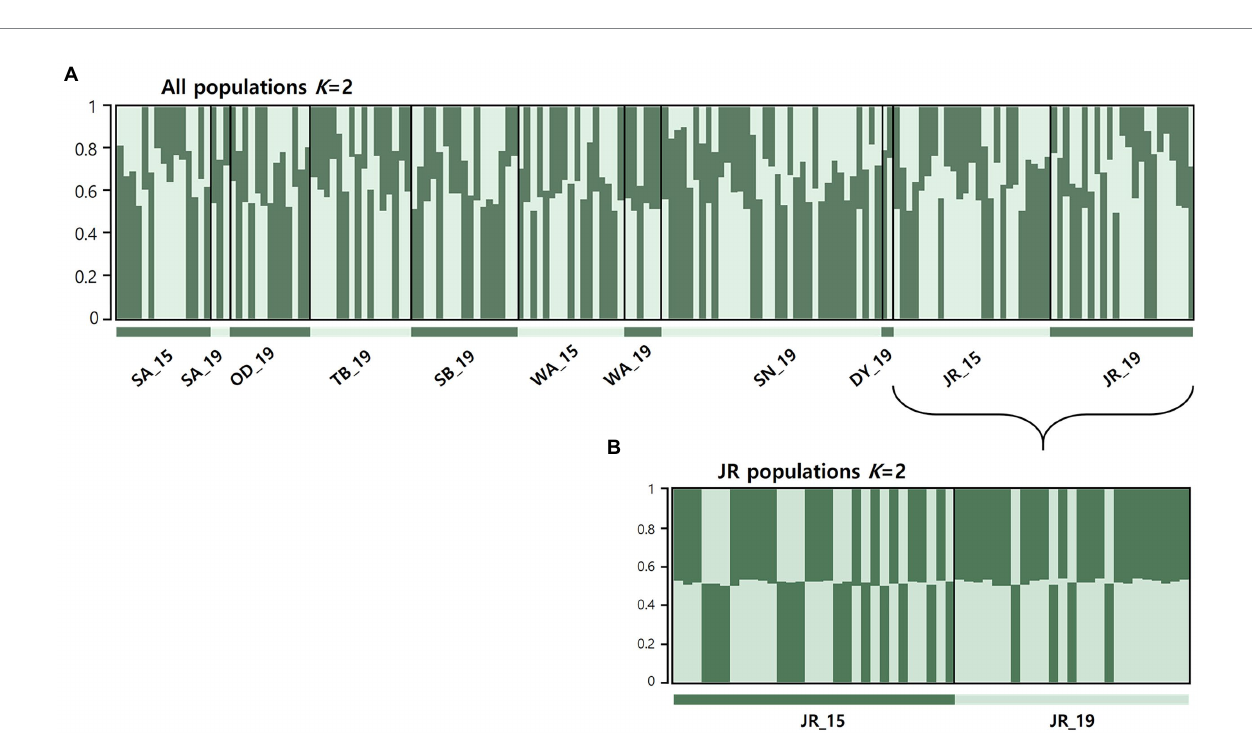
FIGURE 3 Results of genetic structure using a Bayesian population assignment test with STRUCTURE for the national park populations of Apodemus agrarius , based on nine microsatellite loci. Each individual is represented along the x-axis, and the y-axis denotes the probability of that individual belonging to each of the genetic clusters. (A) Analyses of population structure for the all 11 populations combined. (B) Results of the Jirisan National Park population assignment test with STRUCTURE assuming K =